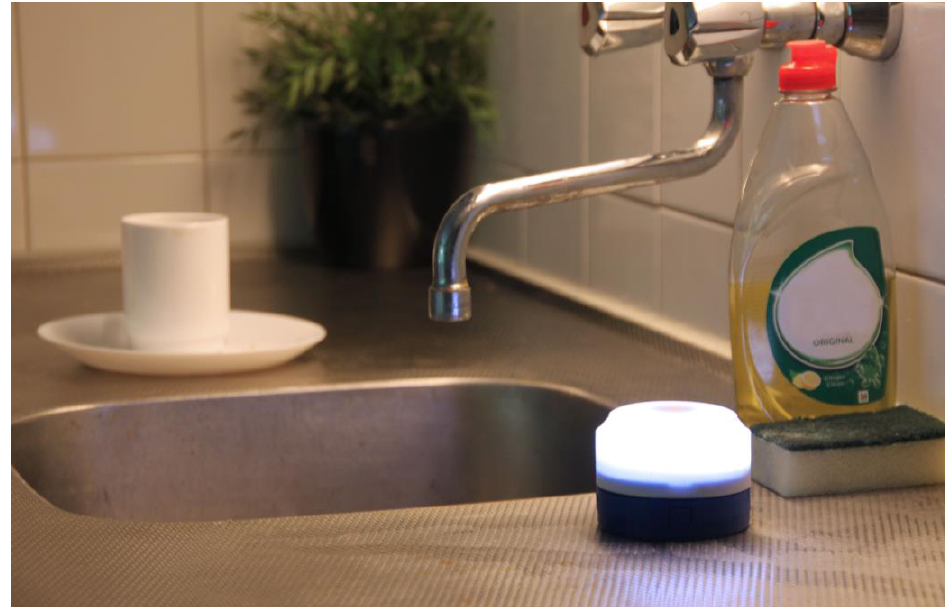
Figure 7. MYDAYLIGHT. Self-installed interactive lights help to create new skilled routines and eventually to transform ones’ lifeworld (Photograph © Laura Beunk).